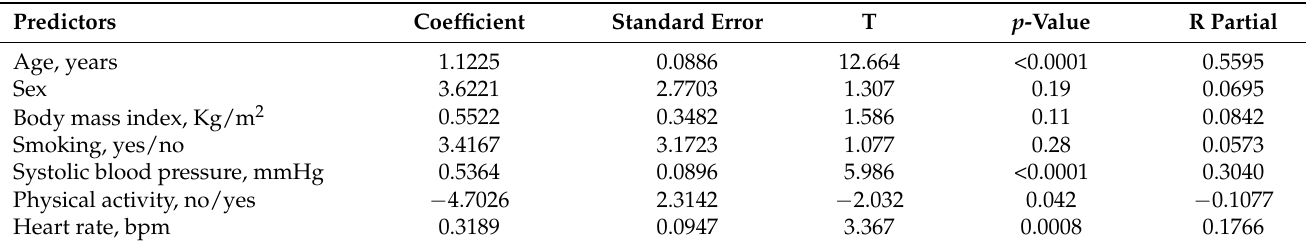
Table 2. Predictors of pressure-strain elastic modulus in a multivariable linear regression analysis. Data from 360 subjects.